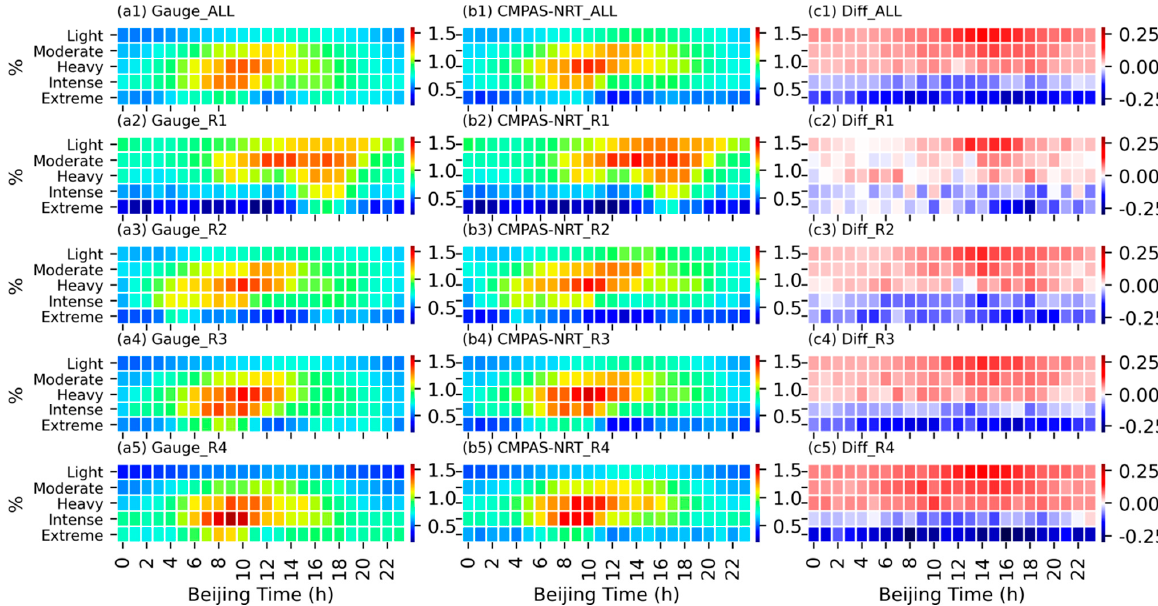
Figure 15. Comparative analysis of the daily variation of the joint probability density function (JPDF) between